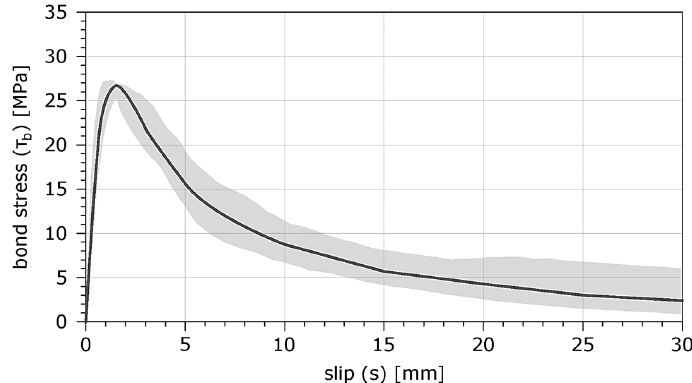
Figure 11. Bond stress–slip curve for POT-12 series (d b = 12 mm).